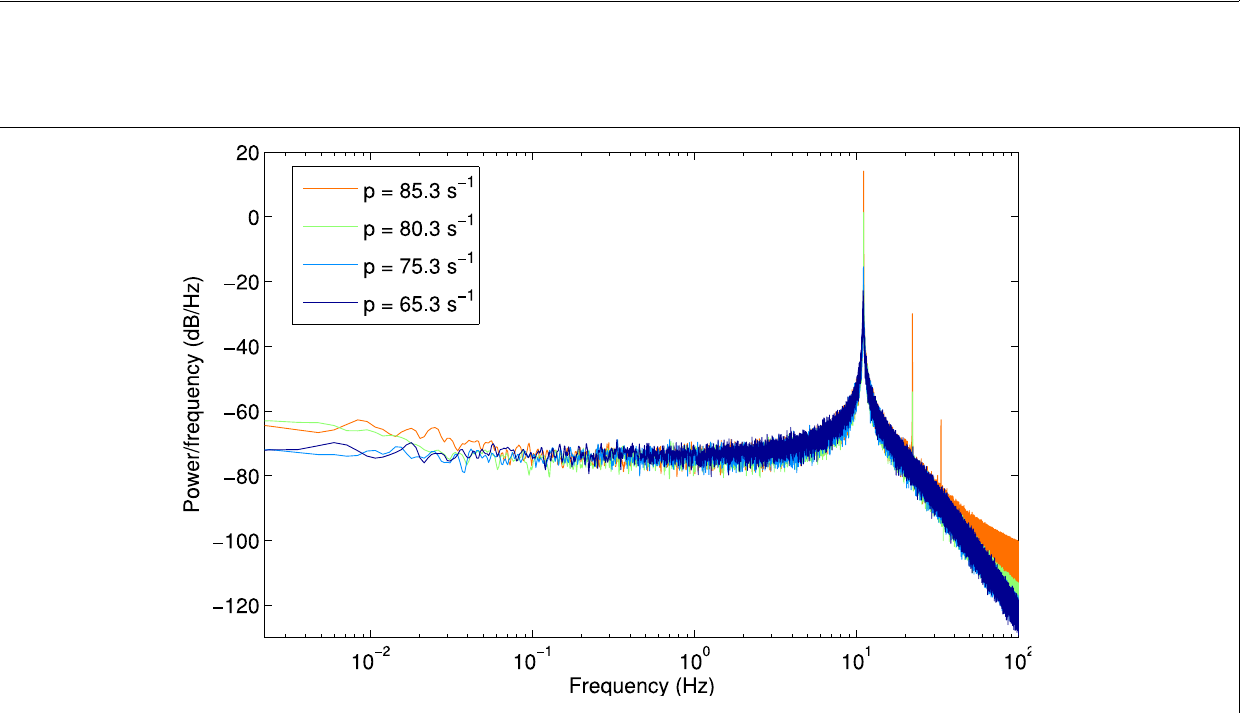
FIGUREA3 | Power spectrum for scenario H3p, using a larger window size of 450s (2,250,000 samples) to show lower frequencies from 2.2 × 10 − 3 Hz.